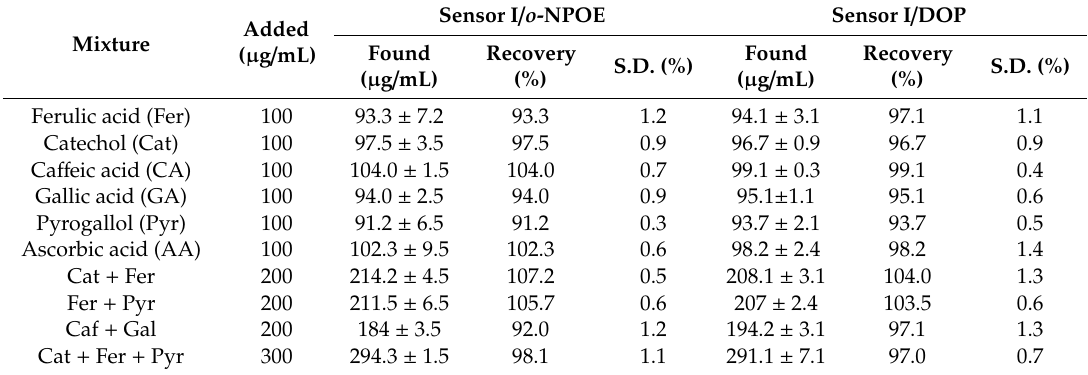
Table 4. Estimation of phenolic antioxidants quantities in mixtures using DCPIP-based membrane sensor.